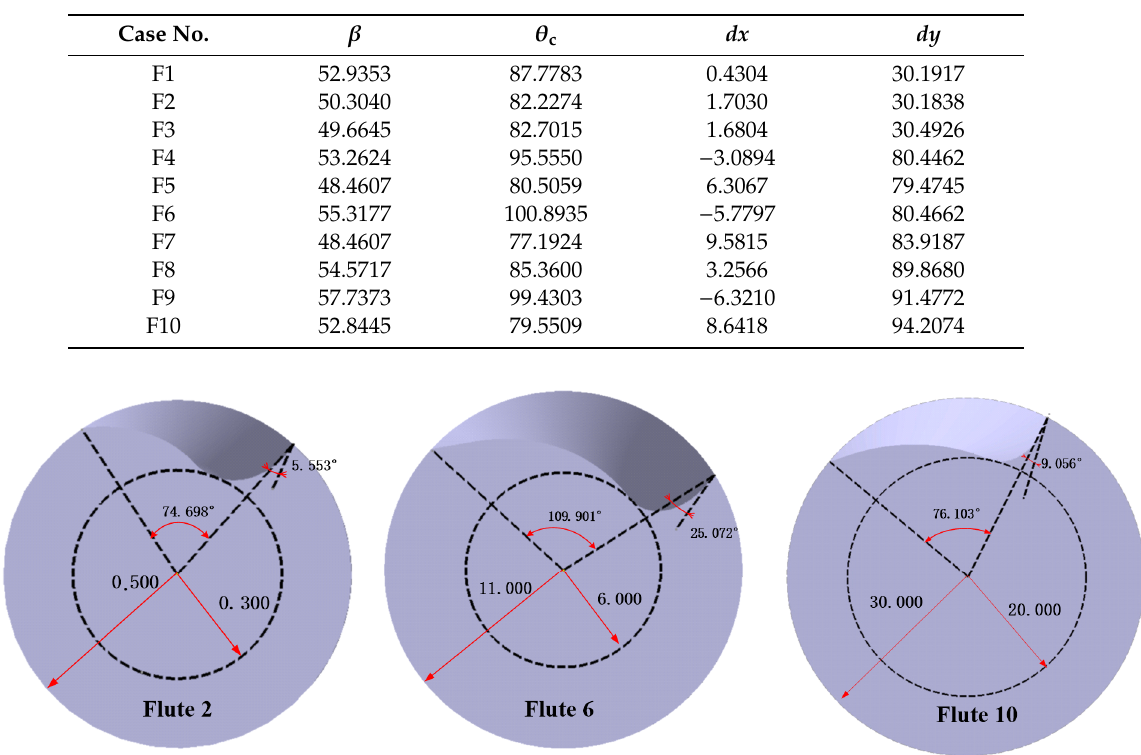
Table 4. Initial setting parameters of grinding wheels calculated by IGA.